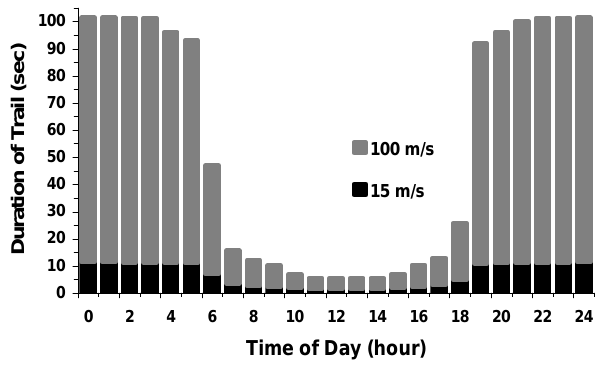
Fig. 5. Effect of the diurnal variation of ionospheric electron den- sity on a 0.01mg meteor’s non-specular trail duration, in seconds, Figure 5. Effect of the diurnal variation of ionospheric electron density on a 0.01mg meteor’s non-specular for two drifts speeds (15m/s and 100m/s). This figure shows the trail duration, in seconds, for two drifts speeds (15 m/s and 100 m/s). This figure shows the differences in differences in equatorial meteor observations (100m/s) and mid- equatorial meteor observations (100 m/s) and mid-latitude observations (15 m/s). The model run was for latitude observations (15m/s). The model run was for a 0.01mg a 0.01 mg meteoroid at a velocity of 50 km/s with an atomic composition of 30 AMU. meteoroid at a velocity of 50km/s with an atomic composition of 30AMU.